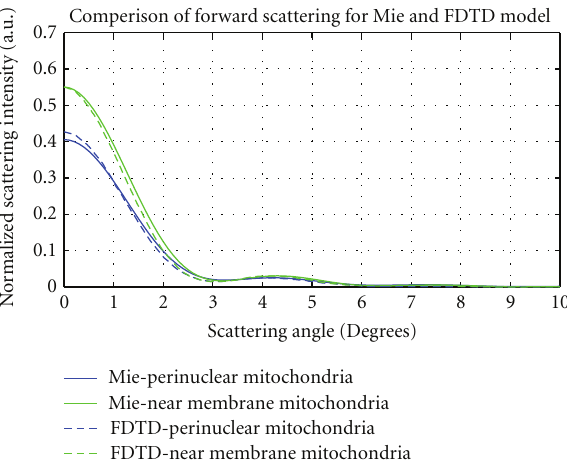
Figure 2: 4 layer sphere model: (1) Nucleus, (2) Perinuclear zone, (3) Mid zone (4) membrane zone. The surrounding is Extra Cellular Fluid (ECF).